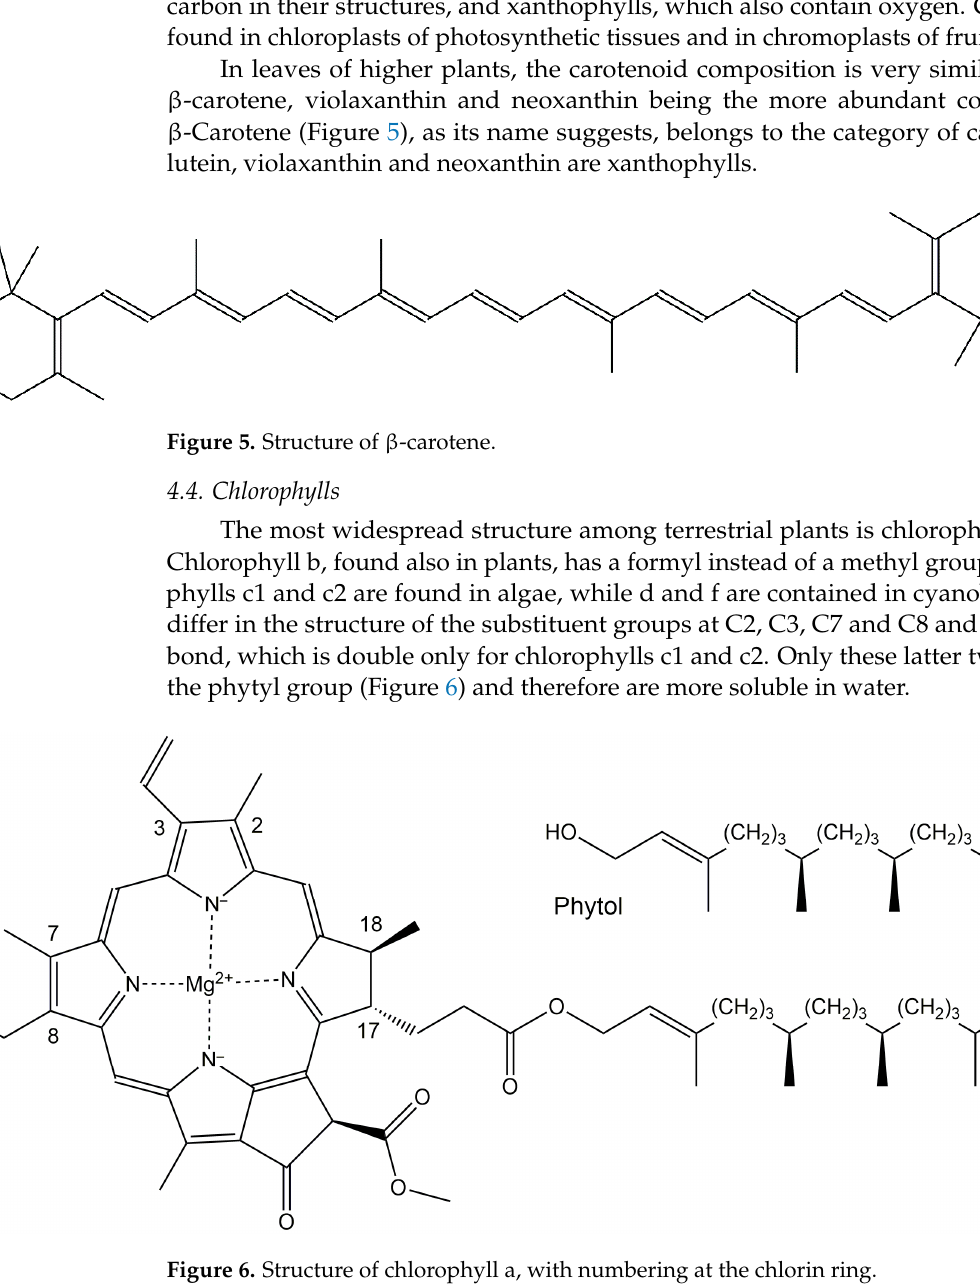
Figure 4. Structures of betanin, betaxanthins and betalamic acid.